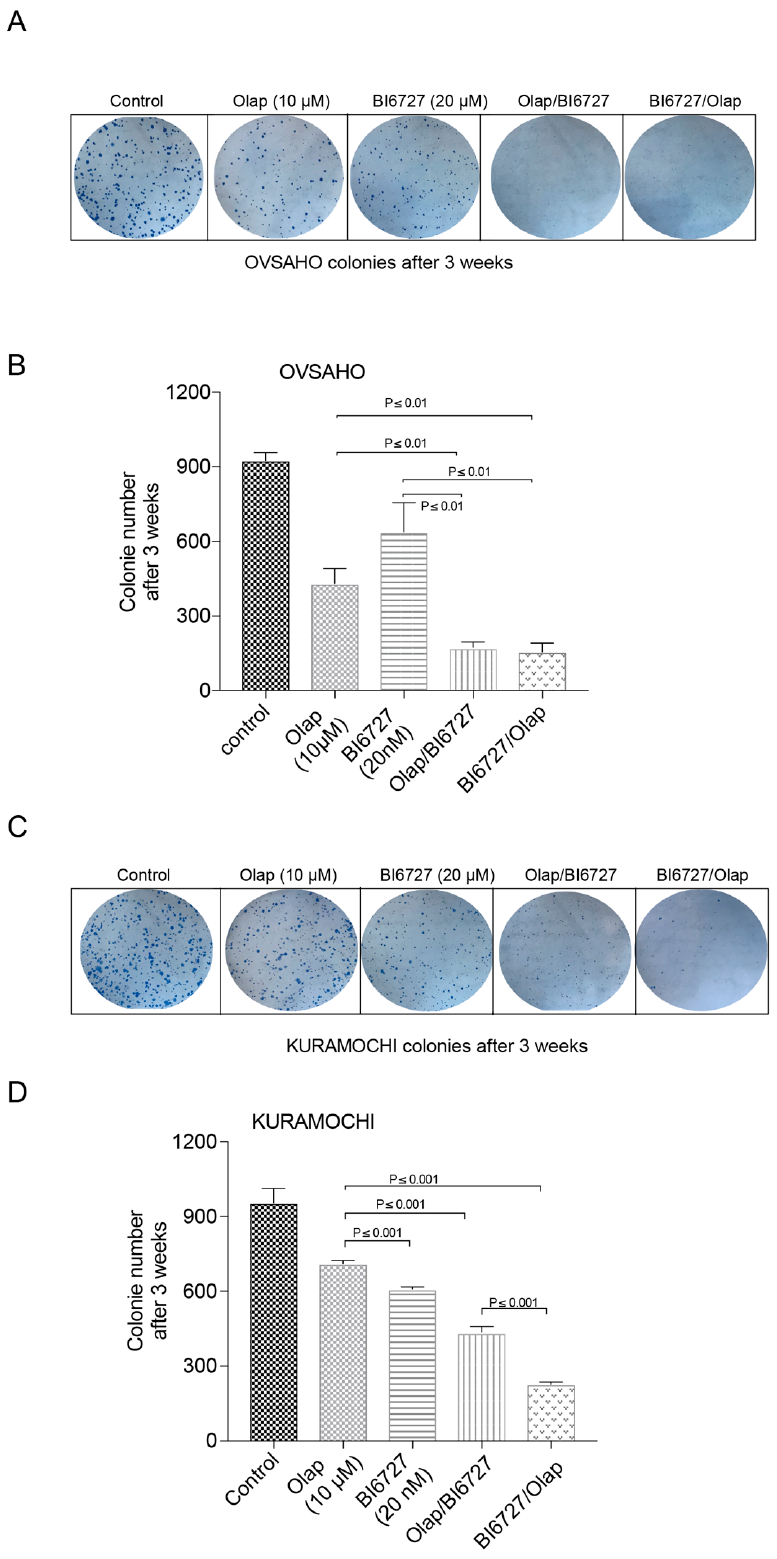
Figure 3. Sequential PARPi and PLKi treatment reduced the 2D clonogenic potential of HR-deficient HGSOC. ( A , C ) OVSAHO and KURAMOCHI cells grown in colonies were subjected to Coomassie blue staining. ( B , D ) The number of colonies was counted and is represented as a bar graph. The results are presented as mean ± SD. ( n = 3, p ≤ 0.001, p ≤